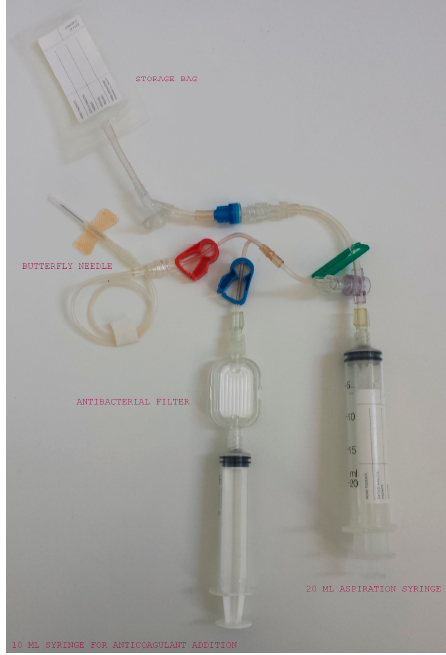
Figure 2. The collection kit: a butterfly needle connected to a 20 mL syringe with a port for addition of anticoagulant and an antibacterial filter (with attached 10 mL syringe) and a 10 mL bag for the storage of the PRP.